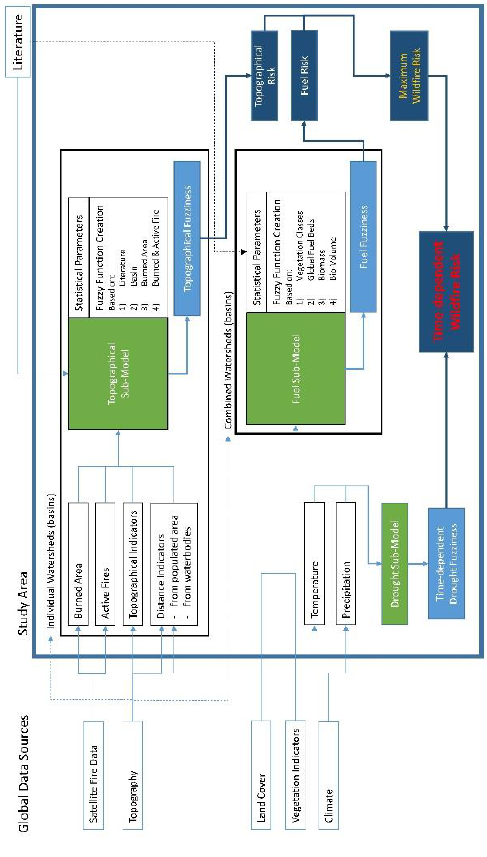
Figure 1: Schematic overview of the model components, and information